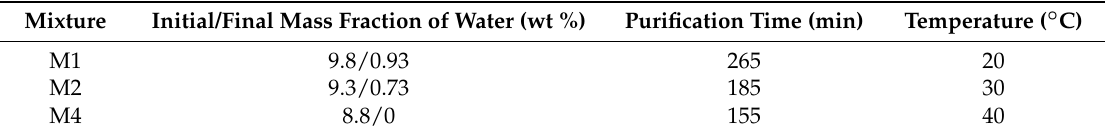
Table 2. Summary of dehydration performances of acetone at 20, 30 and 40 °C through the HybSi ® membrane.